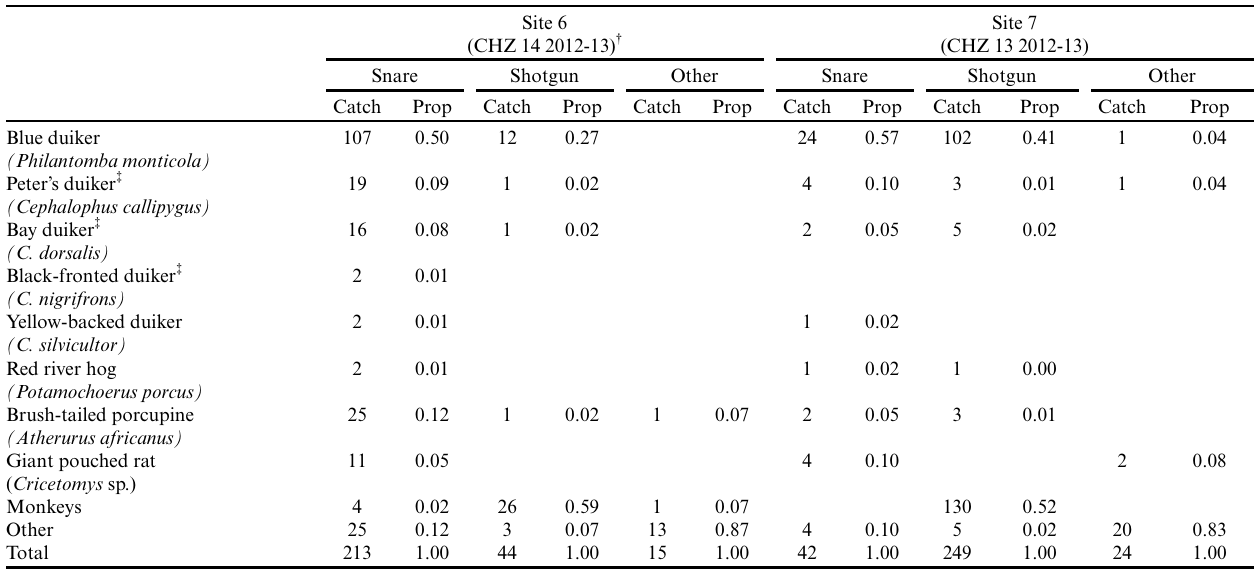
Table 5 . Catch and proportion to the total catch for animal species hunted by the Konabembe at sites 6 and 7.